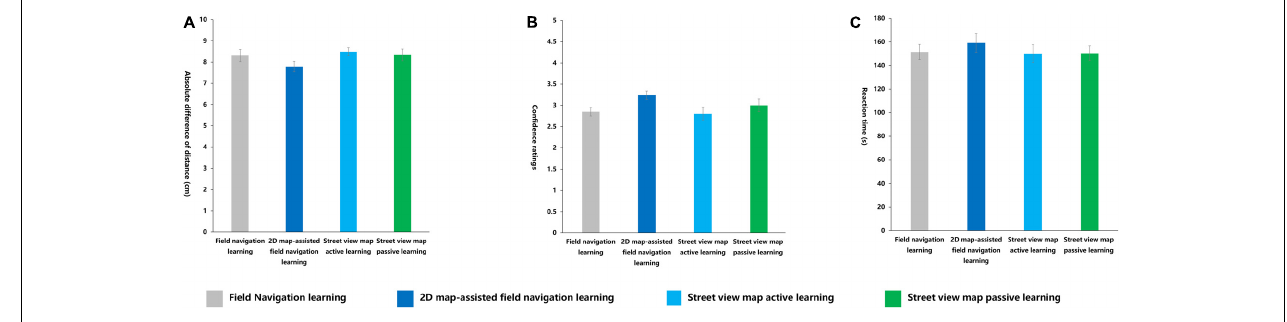
FIGURE 14 | Indexes in distance perception representation task under four learning methods. (A) Accuracy, (B) confidence ratings, (C) reaction time (s).